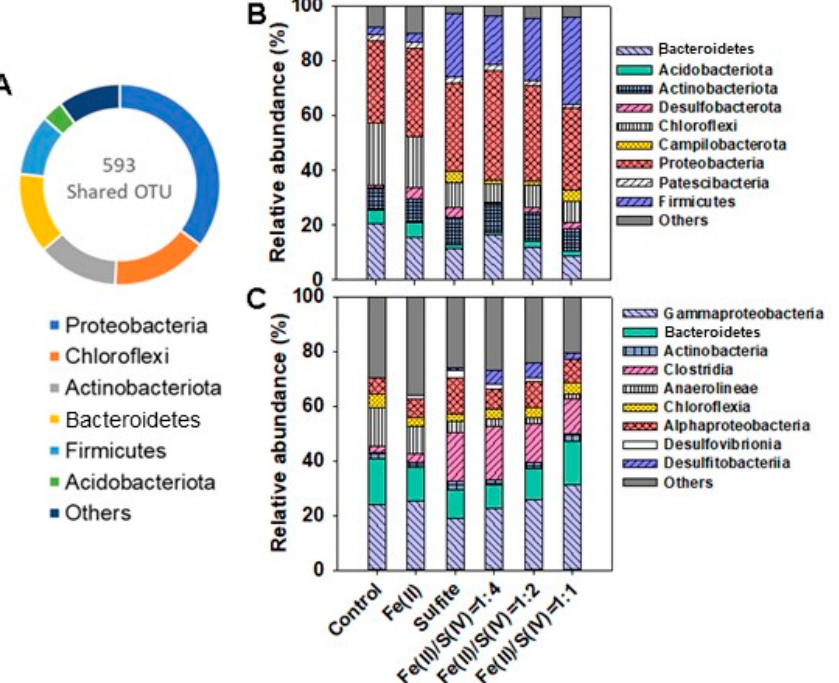
Figure 3. Shared OTU analysis of the six WAS samples ( A ). Relative abundance of functional bacteria at phylum ( B ) and class ( C ) levels.